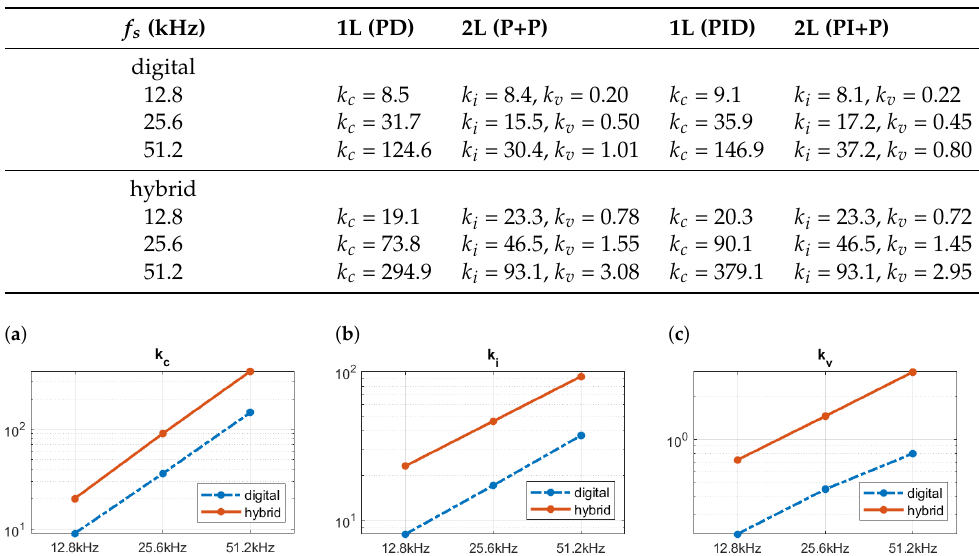
Figure 12. Exemplary surfaces of THD as functions of parameters ( a ) THD( k v ) for 2Lh (P+P) and ( b ) THD( k v , k σ ) for 2Lh (PI+P), ( c ) zoomed in view of ( b ). Table 3. Values of the optimal gains k c , k i , k v for different systems, ( f s = var ).